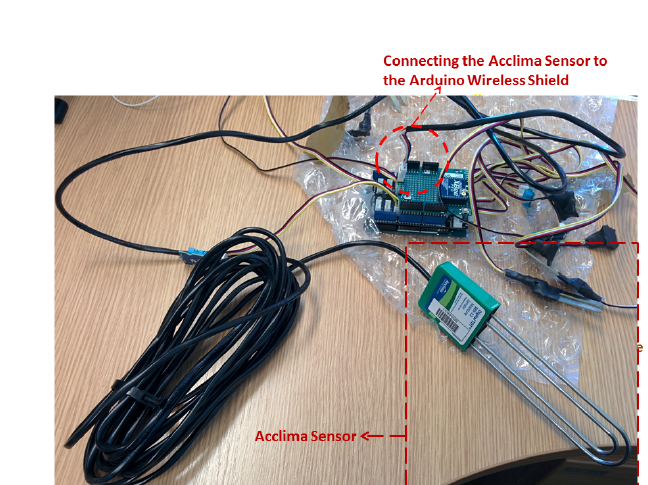
Figure 5. Standard soil node.